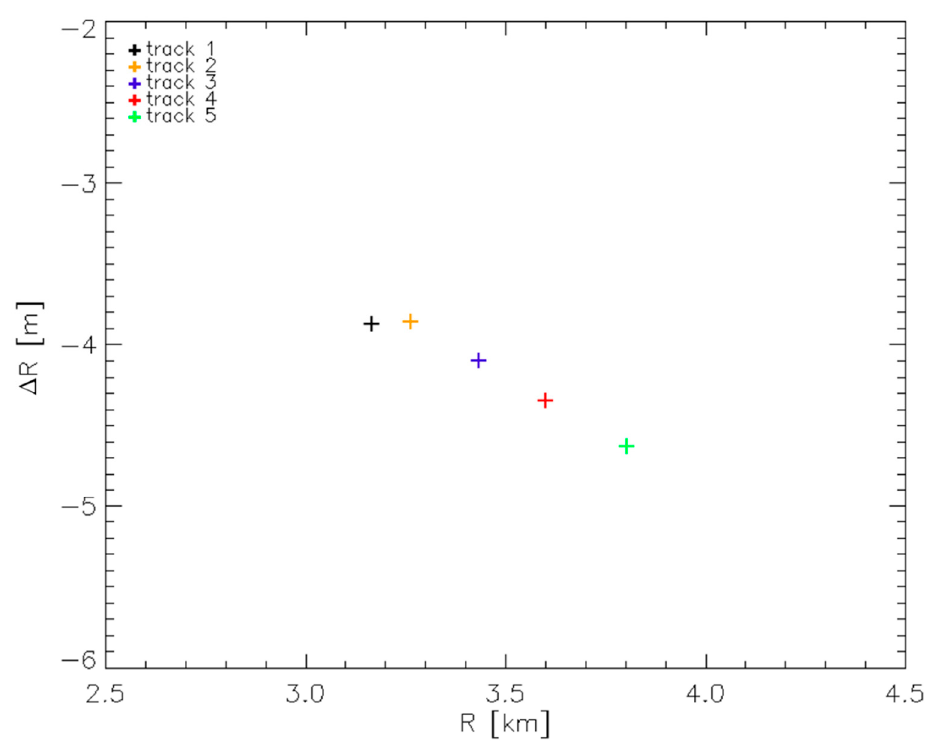
Figure 12. Relevant to Equation (3), to the 5 CRs and the 5 acquisitions considered in the Experiment 7: difference Δ R as a function of the CRs-to-radar distances R. Each color indicates a different radar acquisition as well as a different CR.